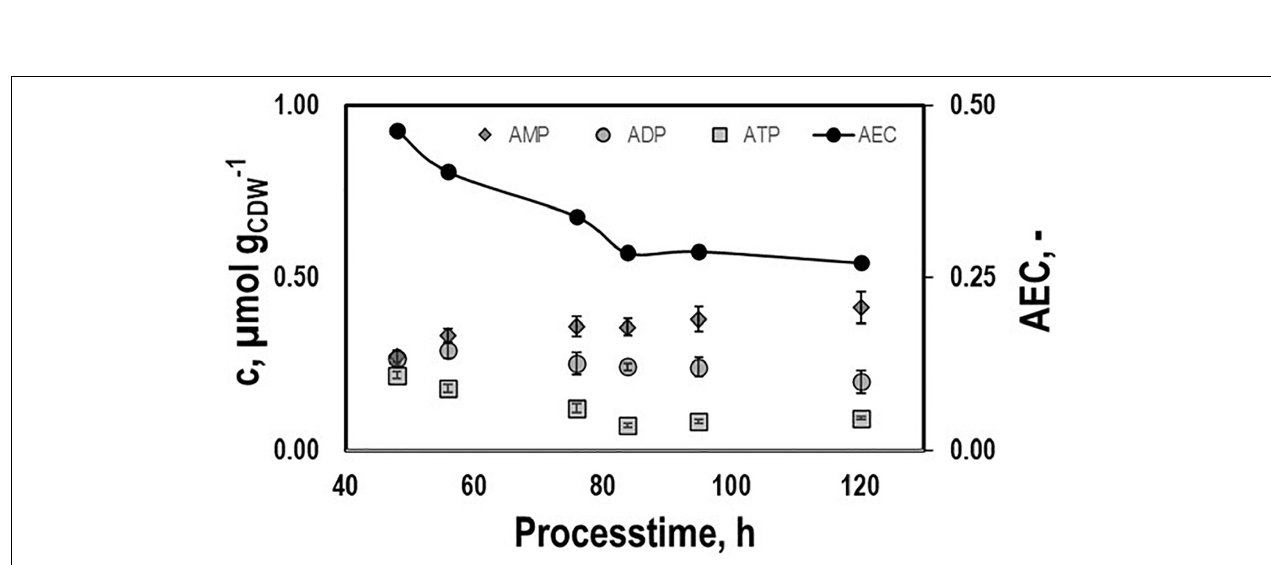
FIGURE 4 | Intracellular pools of AMP, ADP, and ATP and the respective AEC values. Samples were taken during growth phases I and II cultivating CLJU[WT] on syngas in a stirred tank. Error bars are derived from technical replicates.